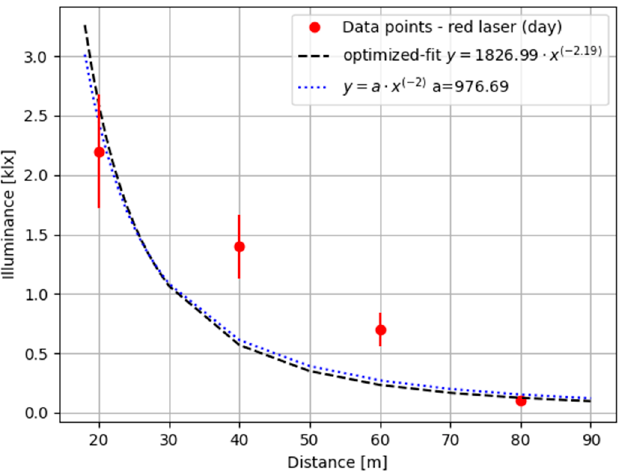
Figure 4. The dependence of the illuminance on the distance of the red laser during the day.